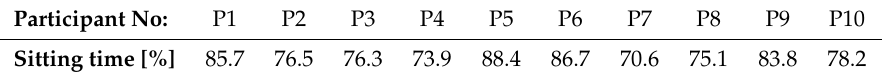
Table 3. Percentage of being in sitting posture of each participant during the 8 h field